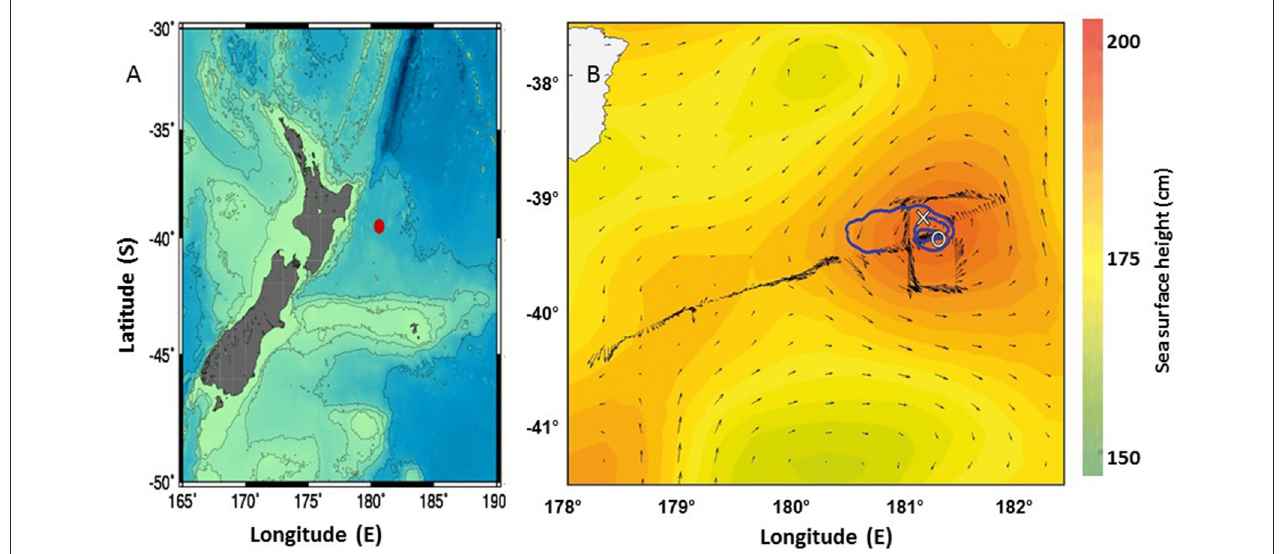
FIGURE 1 | Maps for the larger area around New Zealand with the FeCycle II- spring bloom voyage sited marked as a red dot (A) and the closer area showing the track of the RV Tangaroa (blue solid line) during the FeCycle II- spring bloom voyage (14 September 2008 to 7 October 2008) starting from the center of an eddy. Stations 1 and 2 are marked (X) and (0) respectively (B)